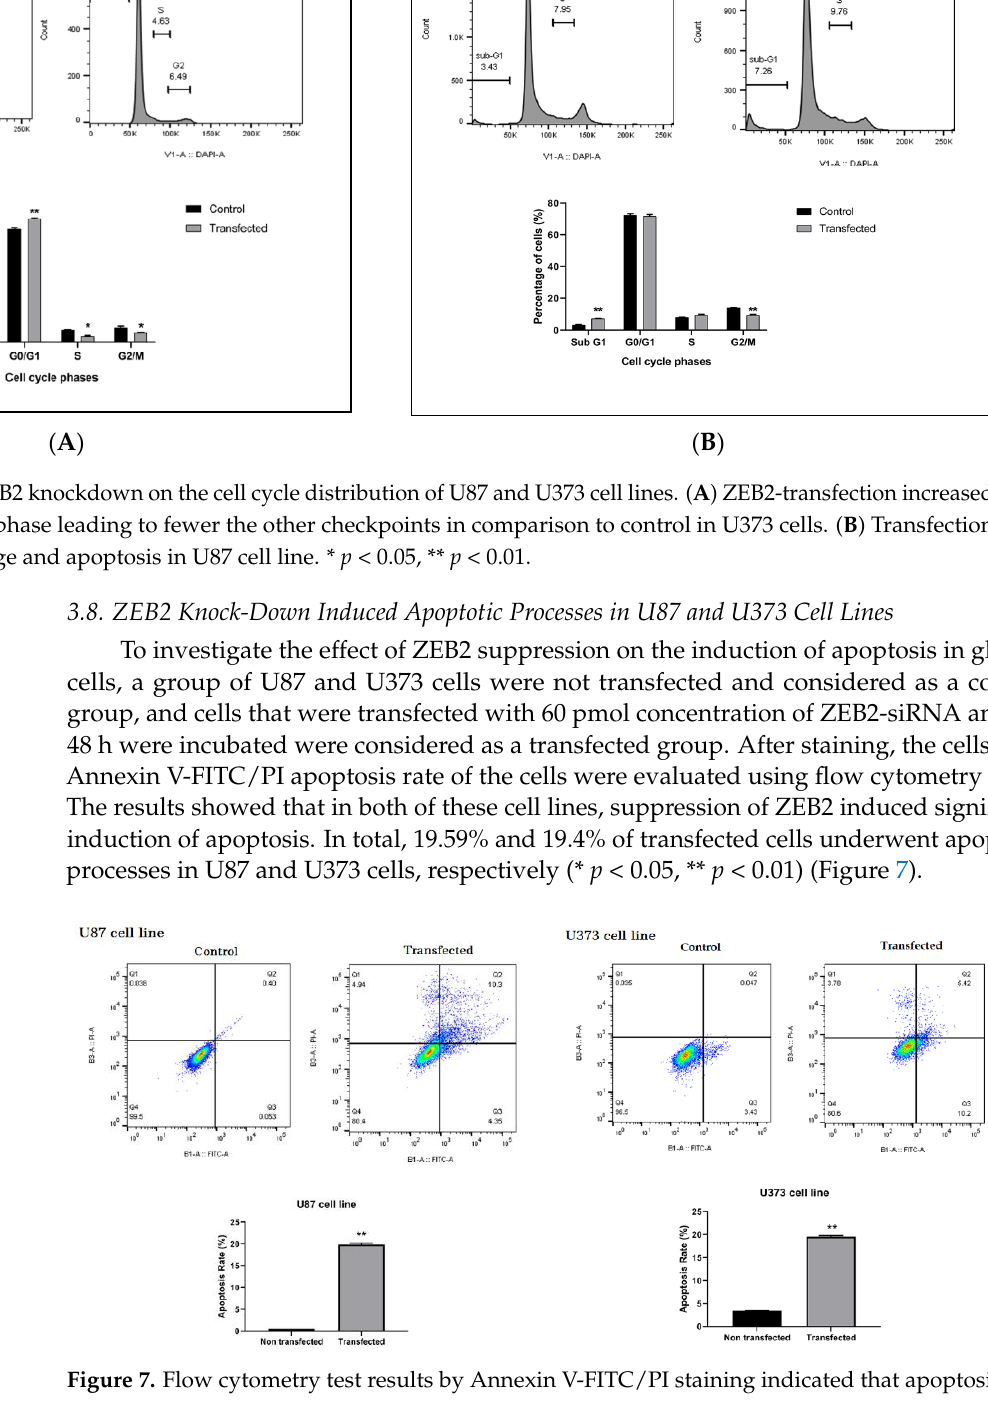
Figure 7. Flow cytometry test results by Annexin V-FITC/PI staining indicated that apoptosis